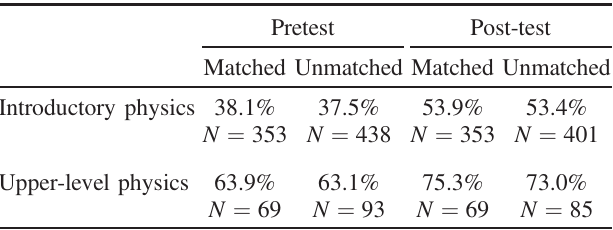
TABLE I. Matched and unmatched data for the introductory and upper-level undergraduate